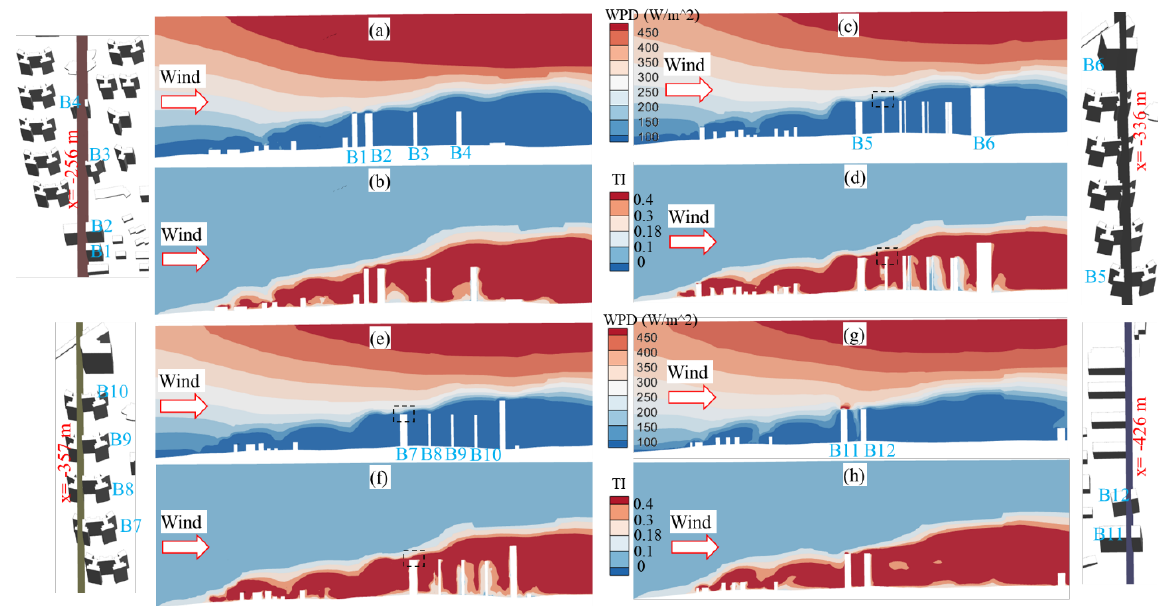
Figure 10. Contours of WPD and TI at various locations in the y - z plane.